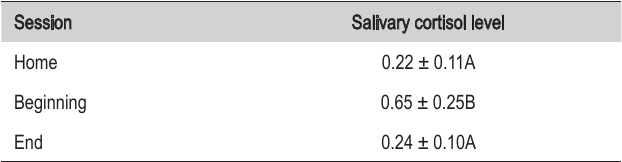
Table 2 - Salivary cortisol levels (µg/dL) averages and standard deviations from collections made in the child’s home, after the beginning and at the end of dental intervention session.